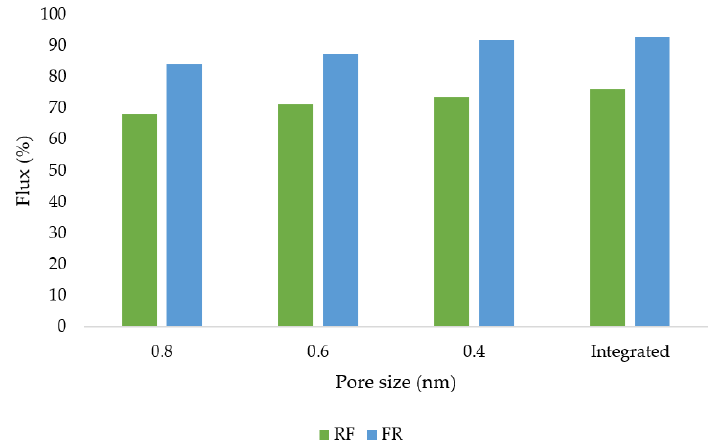
Figure 7. Relative flux and flux